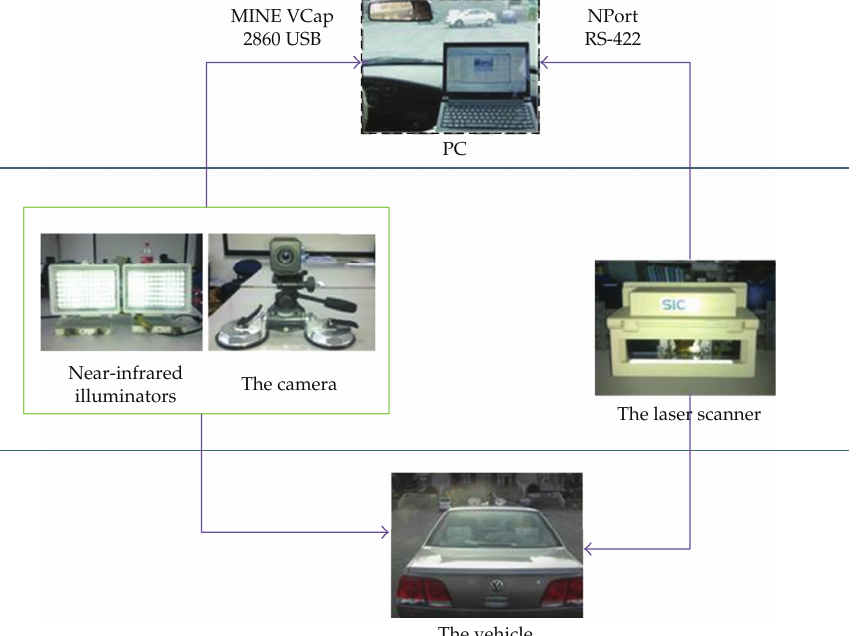
Figure 4: Hardware integration of the